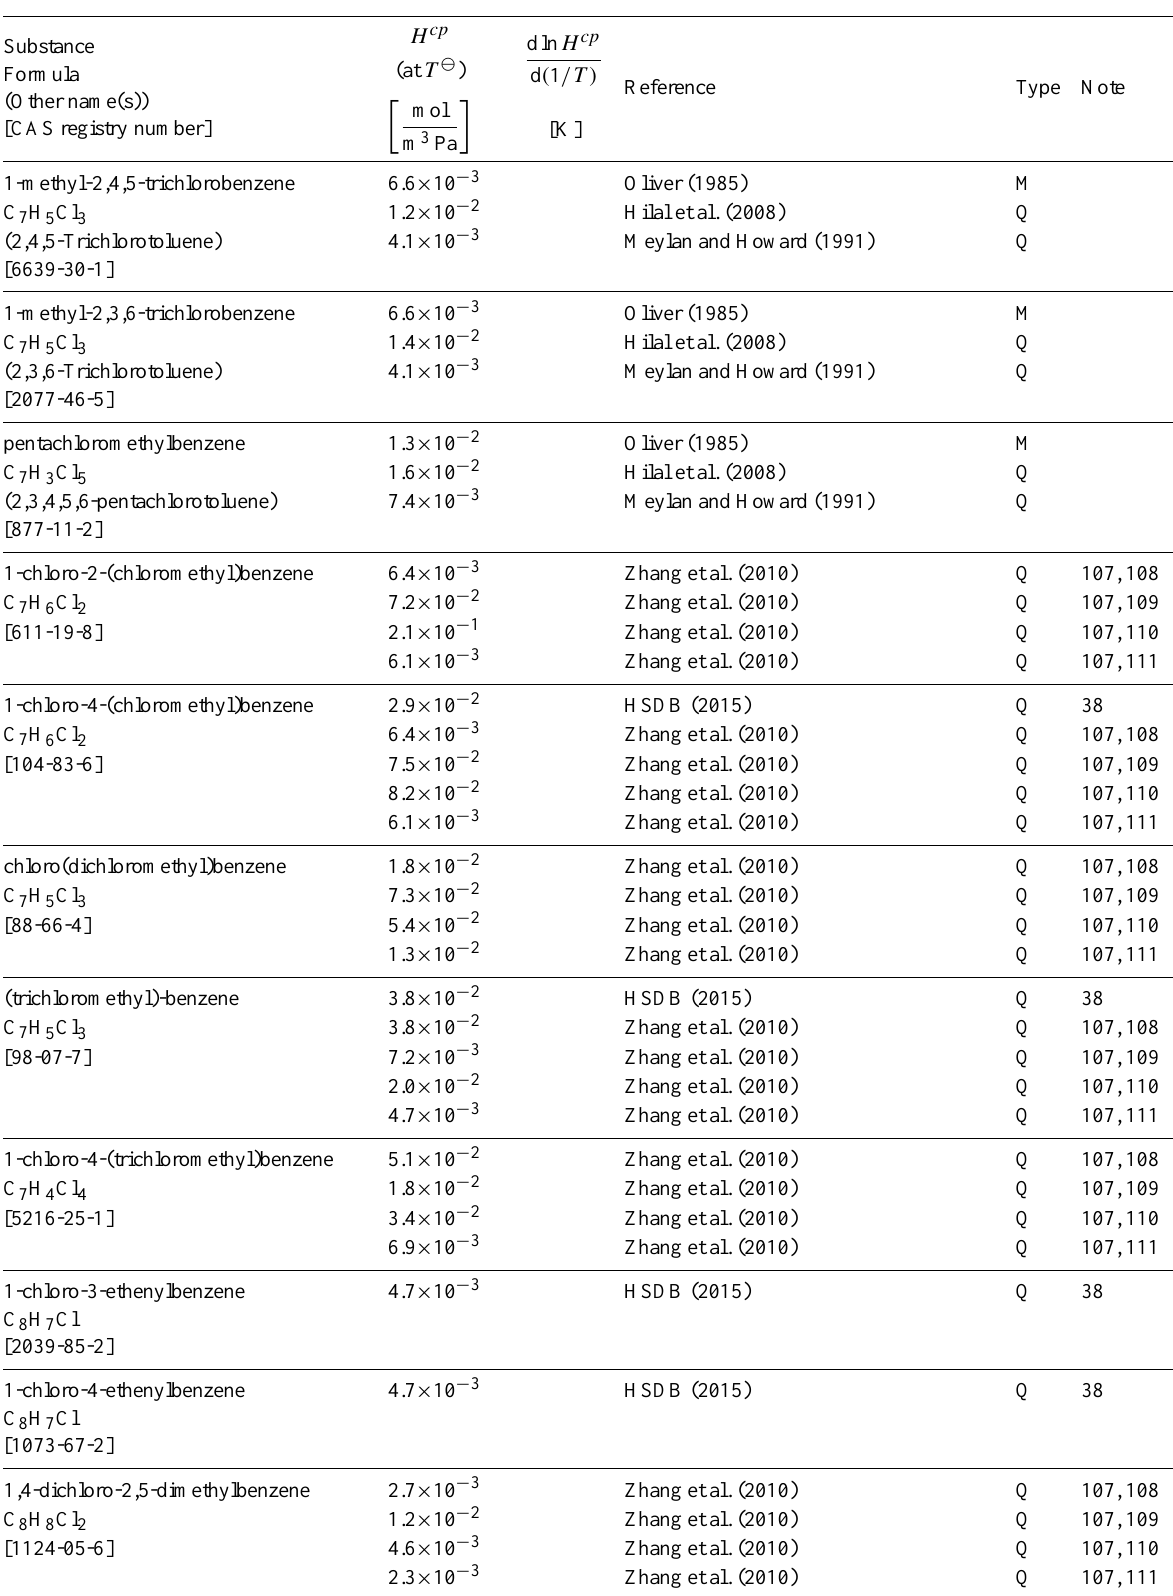
Table 6: Henry’s law constants for water as solvent